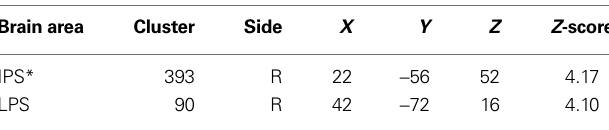
Table 2 | The regions activated for both LM > LMC and LB > LBC contrasts.